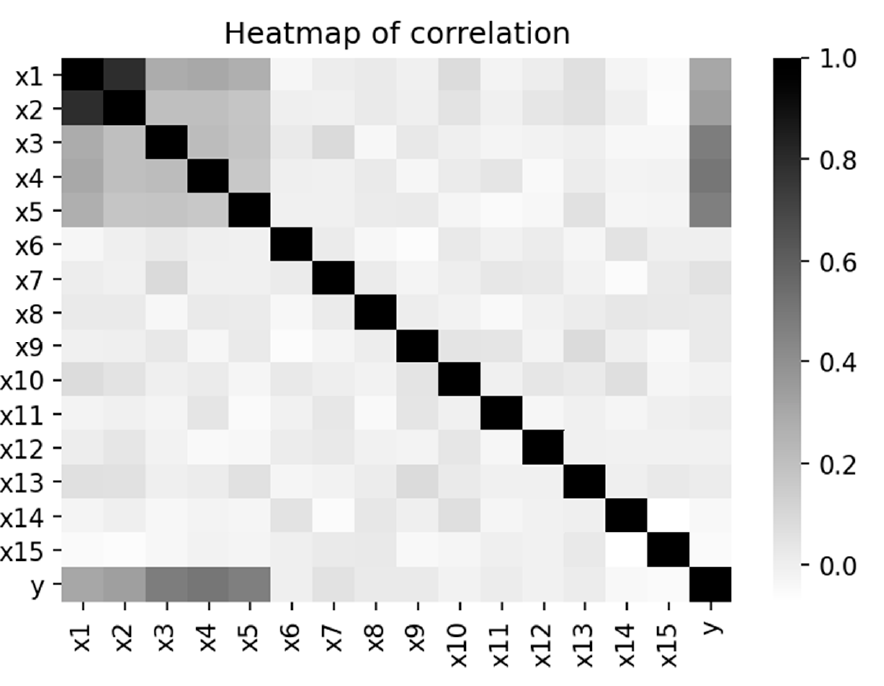
Figure 2. Correlation structure of simulated data. Table 1. Different correlation structures between Y and the predictors. Correlation Coefficient Corresponding to Y X 1 , X